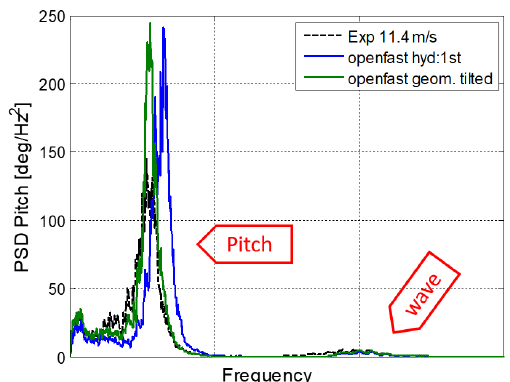
Figure 16. Pitch PSD response comparison between experiment curve, numeric model with platform without tilt and tilted under turbulent wind of 11.4ms − 1 , and irregular waves with H s = 3 . 0m T p = 10 .